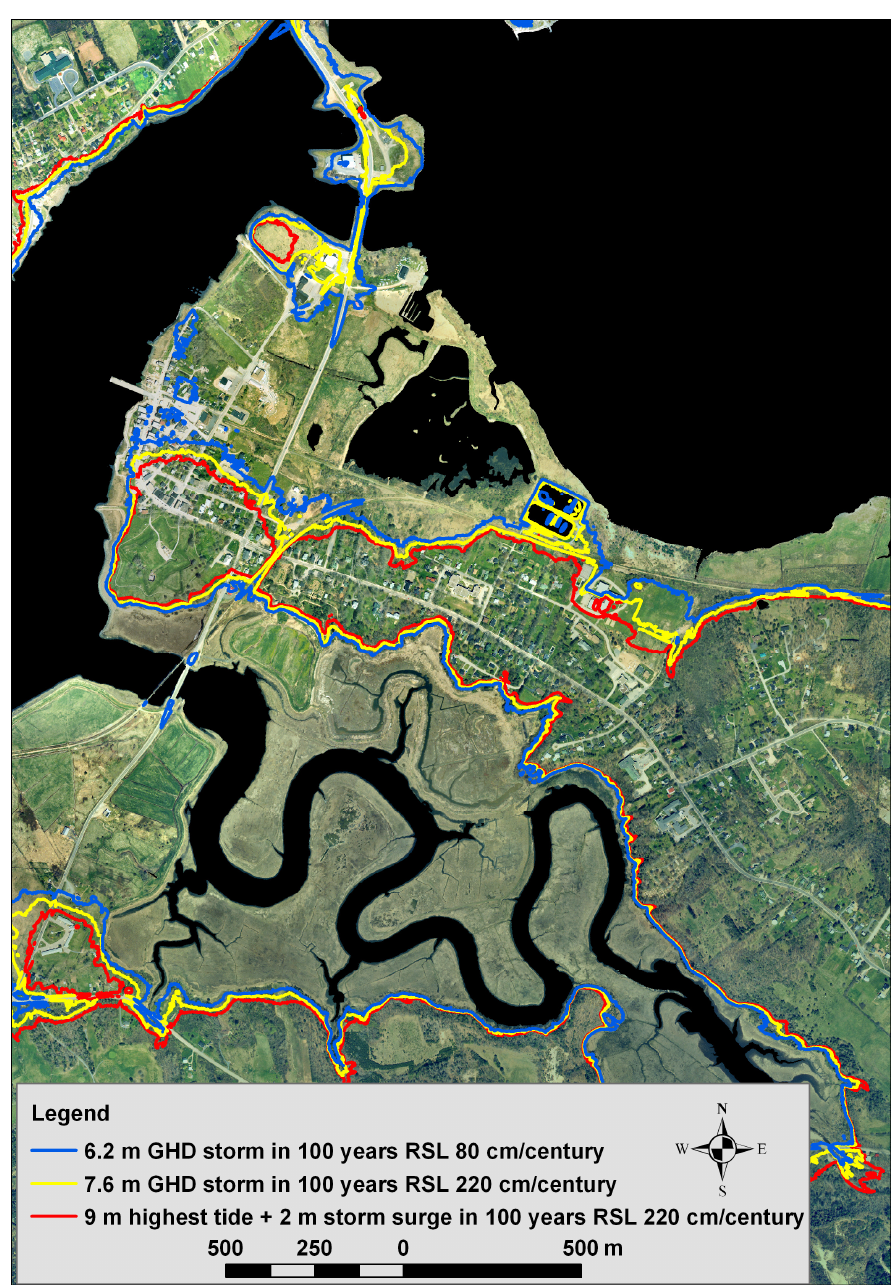
Figure 8. Different possible sea-level rise projections of the Groundhog Day storm in 100 years. Digital orthophoto (May 2003) of Annapolis Royal with a vector outline of flood inundation layers based on the LiDAR